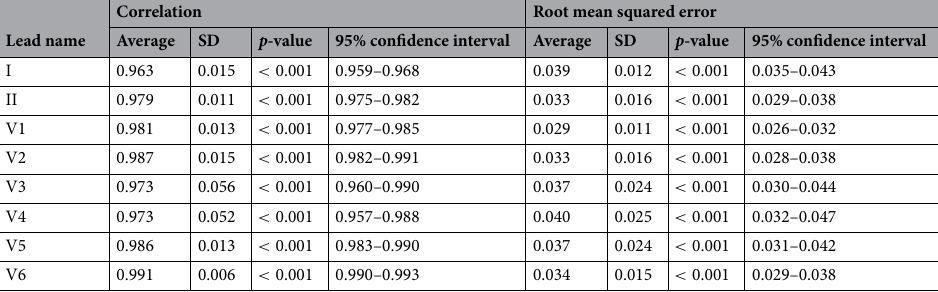
Table 5. Correlation and root mean squared error (RMSE) statistics of the digitised results from selected 45 12 by 1 ECG images and the ground truth digital ECGs (validation 2).